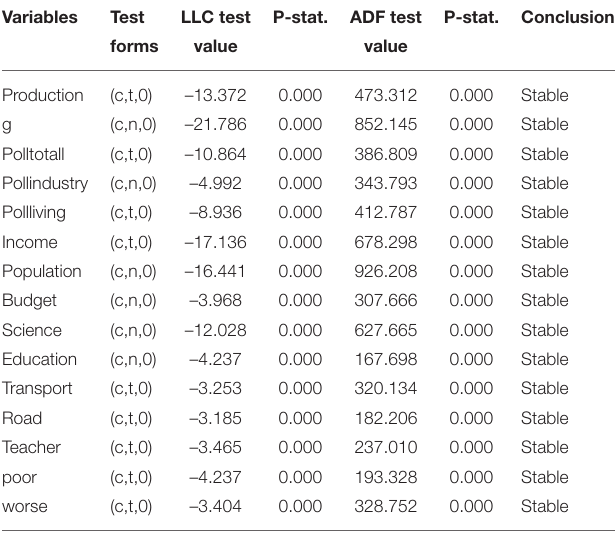
TABLE 3 | Unit root test for panel